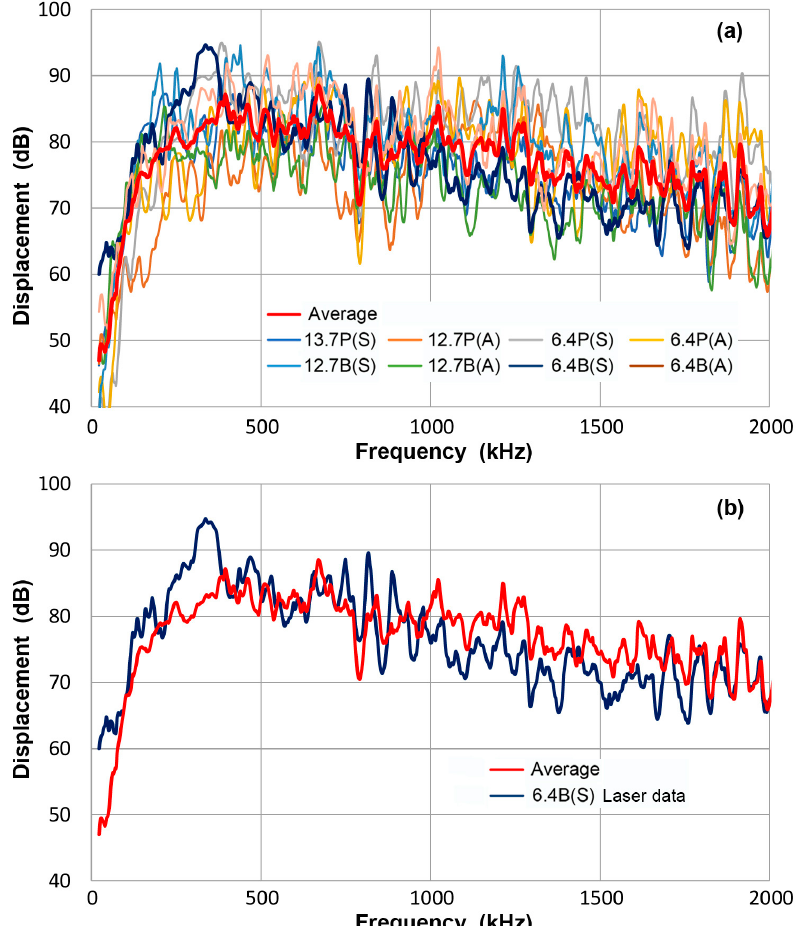
Figure 3. ( a ) FFT magnitude spectrum of normal displacement at 300 mm. Average of eight curves-red, thin bar 6.4B(S)/laser data-dark blue, thick plate 12.7P(S)-blue, thick plate 12.7P(A)-orange, thin plate 6.4P(S)-grey, thin plate 6.4P(A)-yellow, thick bar 12.7B(S)- light blue, thick bar 12.7B(A)-green, thin bar 6.4B(A)-brown. Tests designated by thickness in mm, followed by P or B for plate or bar and (S) or (A) for symmetric or asymmetric excitation. ( b ) Two of the same spectra from ( a ): Average of eight curves-red, 6.4B(S)/laser data-dark